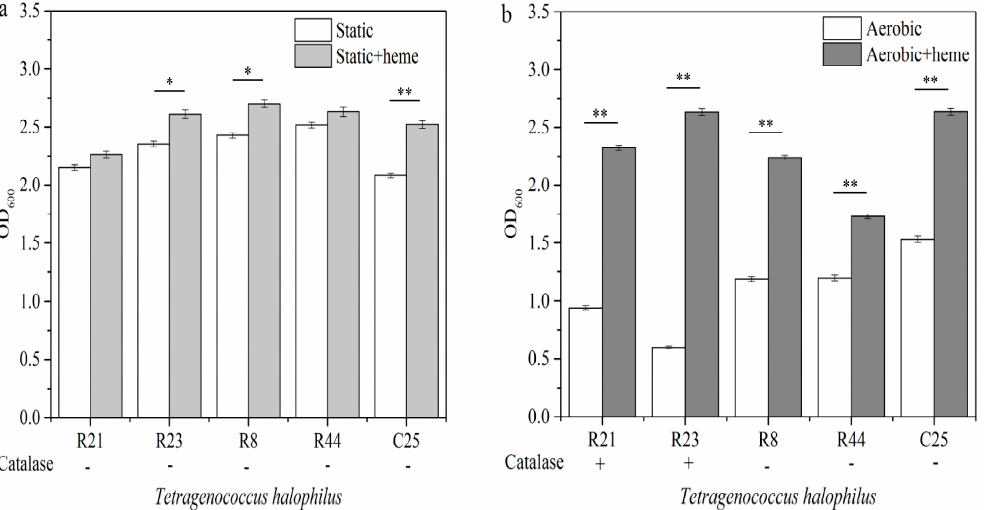
Figure 4. Effect of heme on growth of T. halophilus strains under ( a ) static condition and ( b ) aerobic condition. − /+: negative/positive activity of catalase detected under corresponding conditions. Asterisks mean significant differences among different groups (*, p < 0.05; **, p < 0.01).